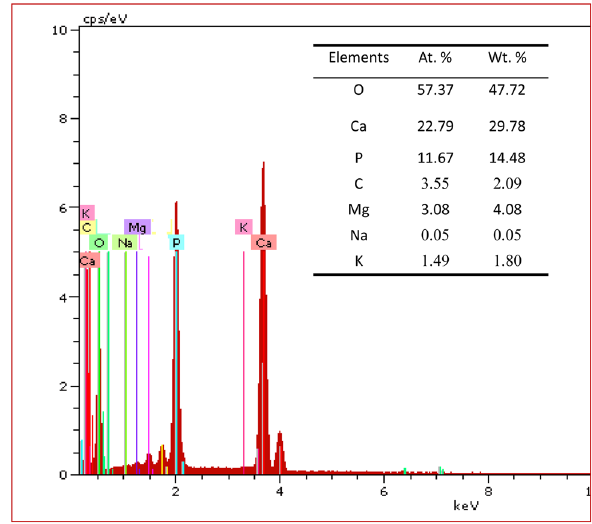
Fig. 13 EDX of SBF treated CAP-AMB scafold after 7 days of SBF treatment at pH of 7.4 and temperature of 37